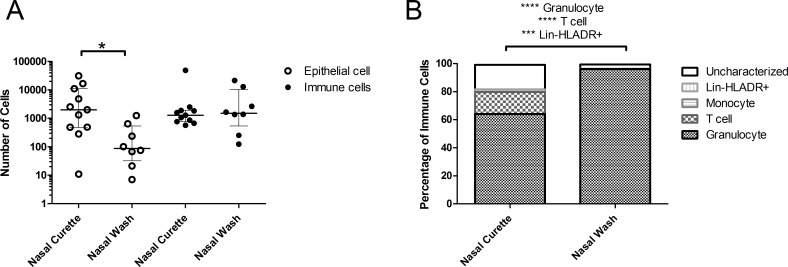
Comparison of samples collected by nasal wash and nasal curette.(A) Epithelial (open circles) and immune (closed circles) and cell yields were compared between nasal wash pellets and nasal curette samples. Individuals samples and median and interquartile range are shown. (B) Median proportions of granulocytes, T cells, monocytes, lineage- HLA-DR+ and uncharacterized cells among immune cells in nasal curette (n = 139 individuals) and nasal wash (n = 8) samples. *p < 0.05, ***p < 0.001, ****p < 0.0001 Mann-Whitney test.